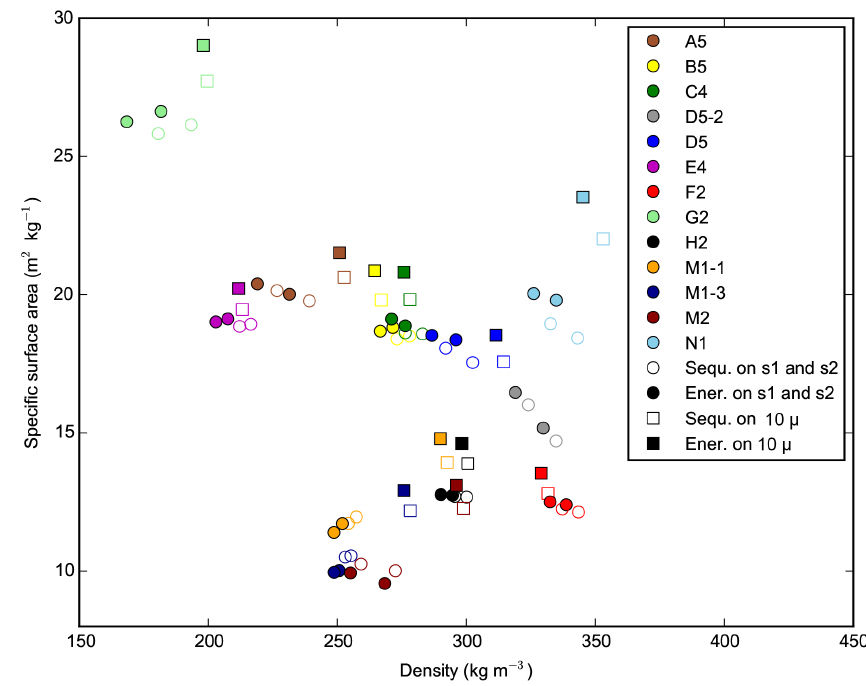
Figure 15. Specific surface area as a function of density for the entire set of images and the two different binary segmentation methods. The sequential filtering (“Sequ.” in the legend) was applied with σ = 1.0 voxel, T = T hagen and d = 1.0 voxel. The energy-based approach (“Ener.” in the legend) was applied with r = 1.0 voxel. The surface area was computed with the Crofton